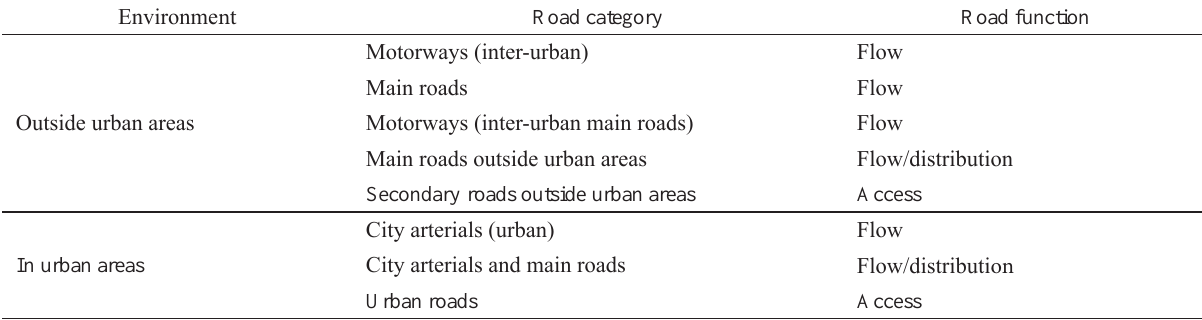
Table 3. Road categories and road functions according The JOINT OECD/ECMT report in 2006 Environme